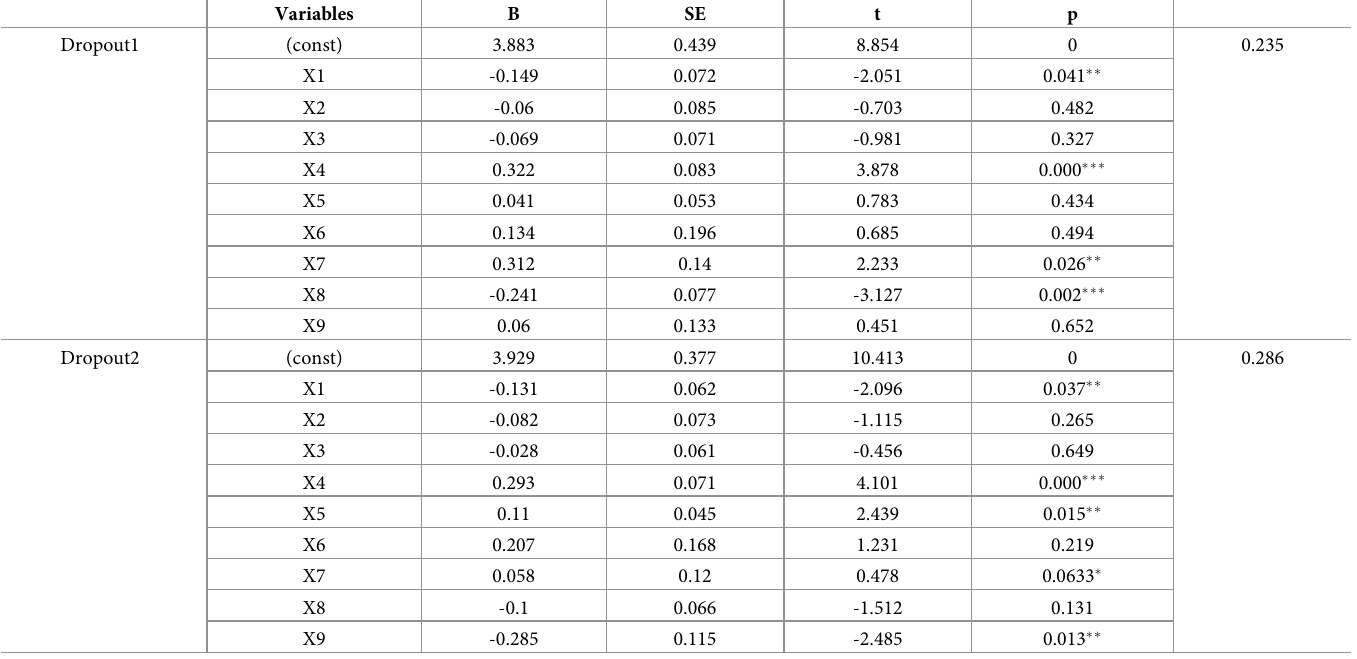
Table 7. Results of Chow verification for dropout.